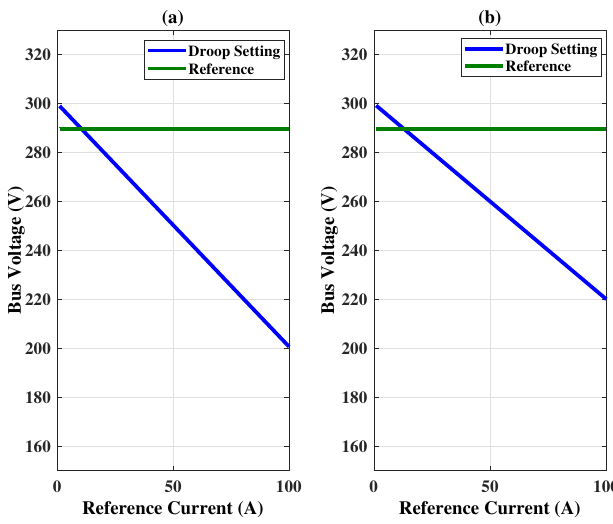
Figure 16. Linear droop control relationships for ( a ) wind source and ( b ) conventional source for first simulation.